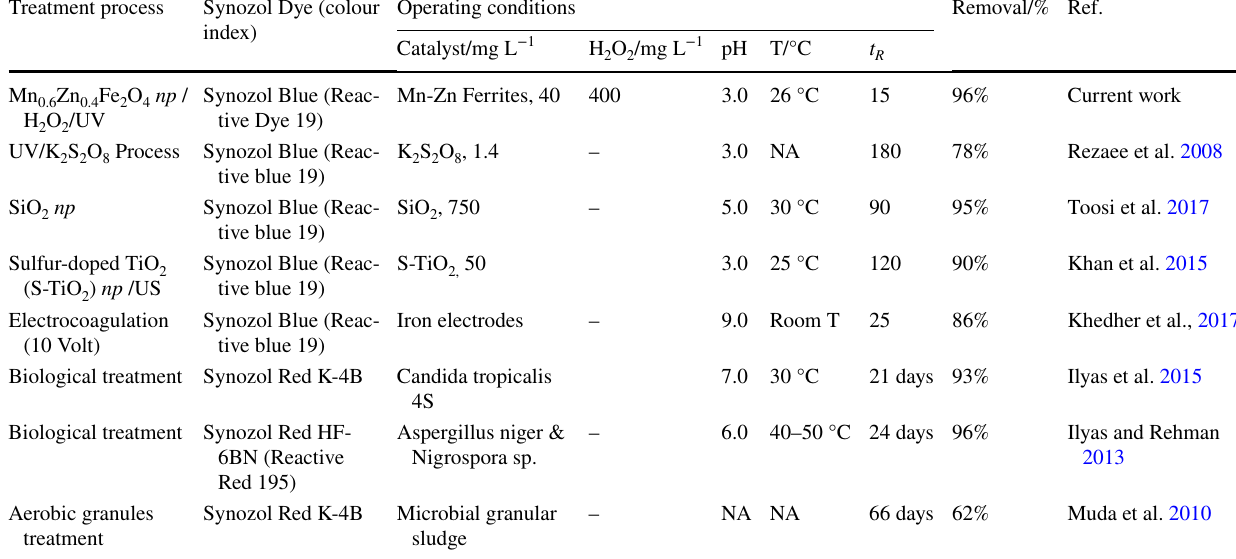
Table 3 Comparison of different treatment methodologies for Synozol dye contaminated wastewater matrix*